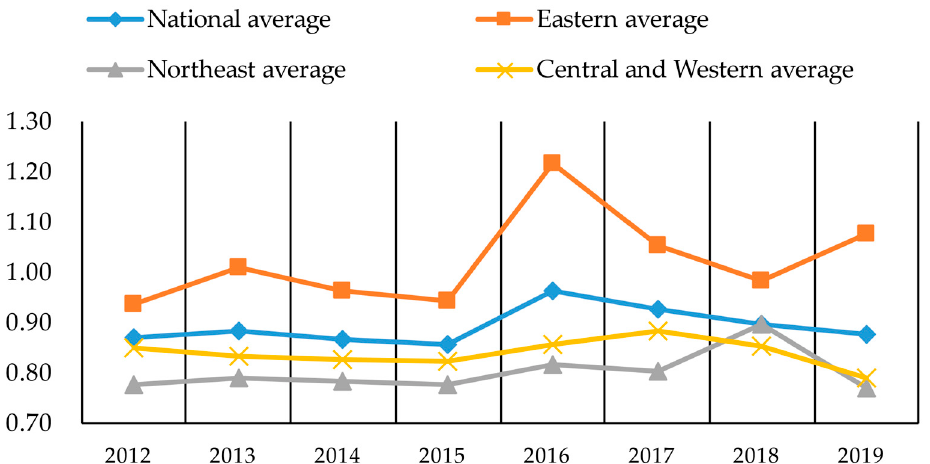
Figure 2. Trend of green transformation efficiency of resource industries in three major regions of China, 2012–2019.